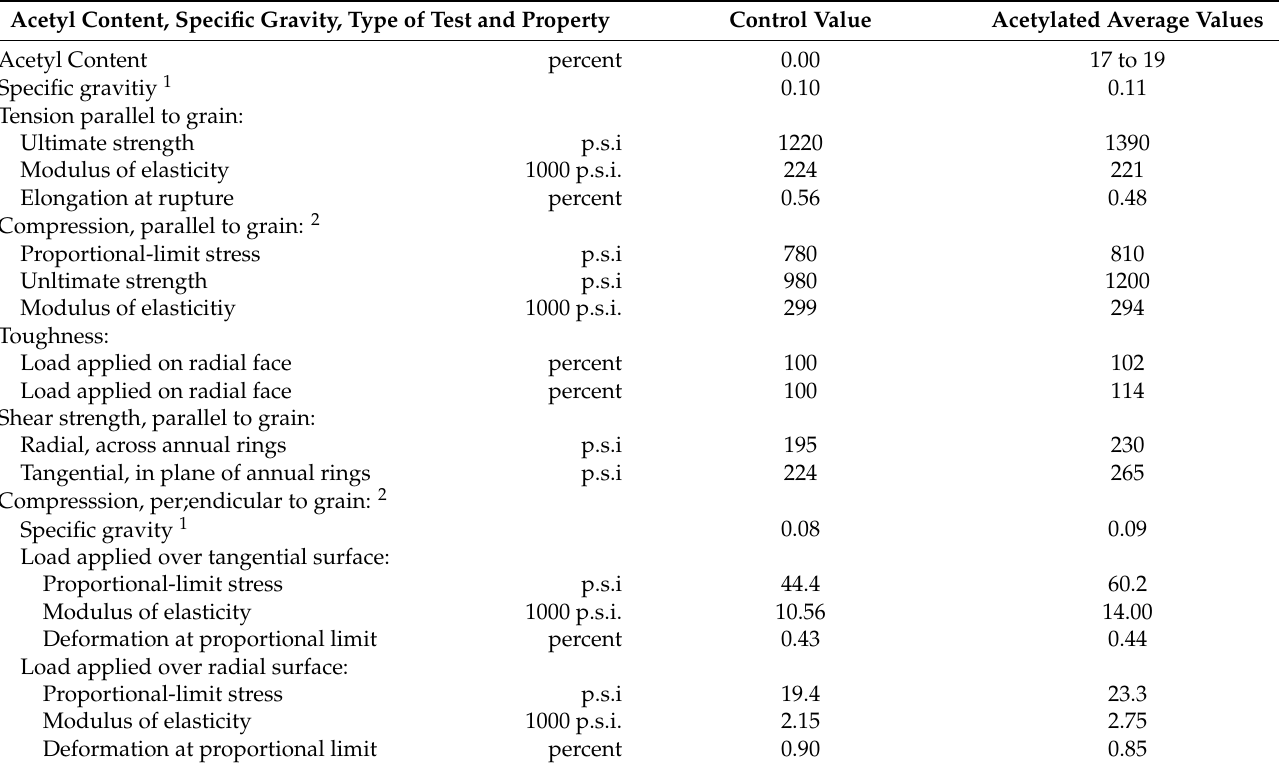
Table 7. Mechanical properties of control and acetylated solid balsa wood